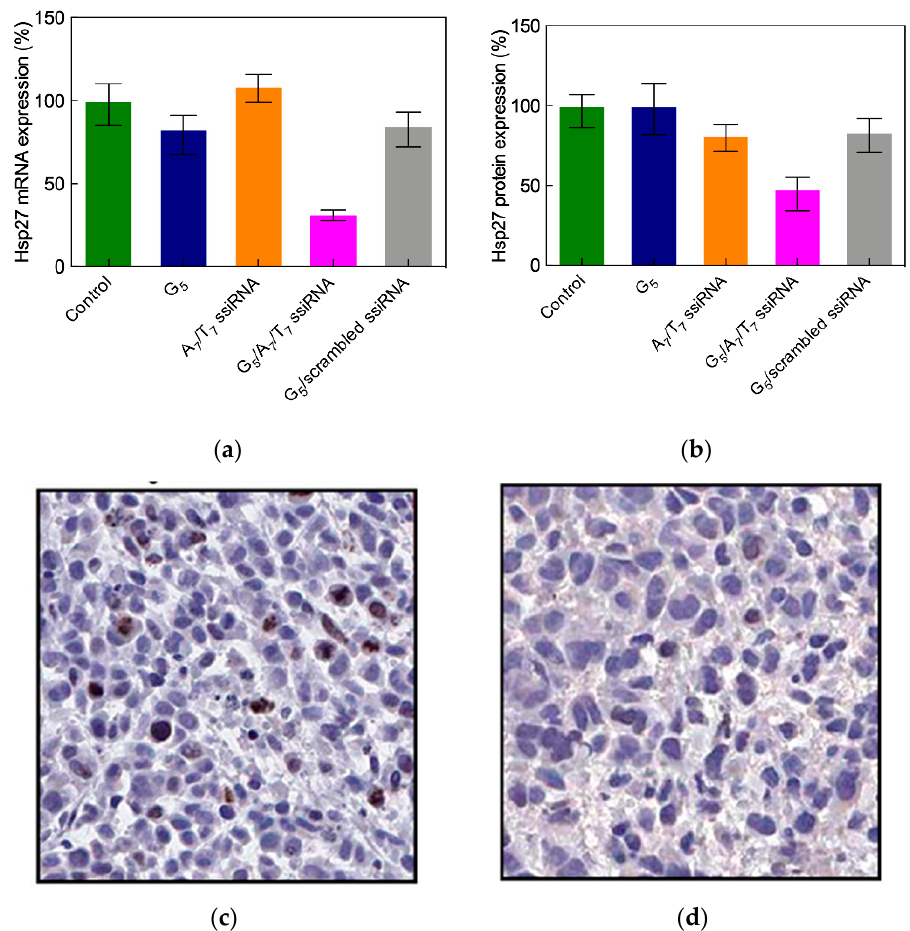
Figure 18. In vivo downregulation of Hsp27 at both mRNA ( a ) and protein ( b ) levels achieved after treating PC-3 cell xenografted nude mice with intratumoral injection of Hsp27 A 7 /T 7 ssiRNA/G 5 complex, buffer solution (control), the dendrimer G5 alone, the A7/T7 ssiRNA alone and a scrambled (non-silencing) ssiRNA sequence/G 5 complex (all used as negative controls). ( c ) Evaluation of tumor cell proliferation via immunohistochemistry using Ki-67 staining after treatment with a scrambled ssiRNA sequence/G 5 (left) and the Hsp27 A 7 /T 7 ssiRNA/G 5 complexes (right). Adapted from [56], with permission of the American Chemical Society.